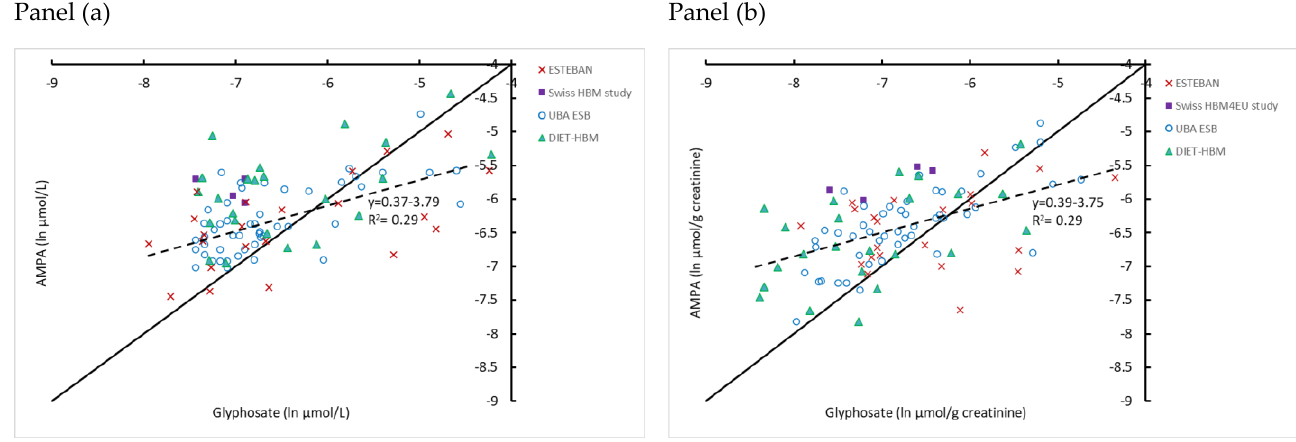
Figure 2. HBM4EU harmonized data (Germany (UBA ESB), Switzerland (Swiss HBM4EU study), France (ESTEBAN), Iceland (DIET-HBM)) for glyphosate and AMPA in adults. Data (>LOQ) are expressed on a natural logarithmic scale. The 1:1 line (full line) is indicated. Panel ( a ): µg/L scale and panel ( b ): µg/g creatinine scale. Values below LOQ are not included.